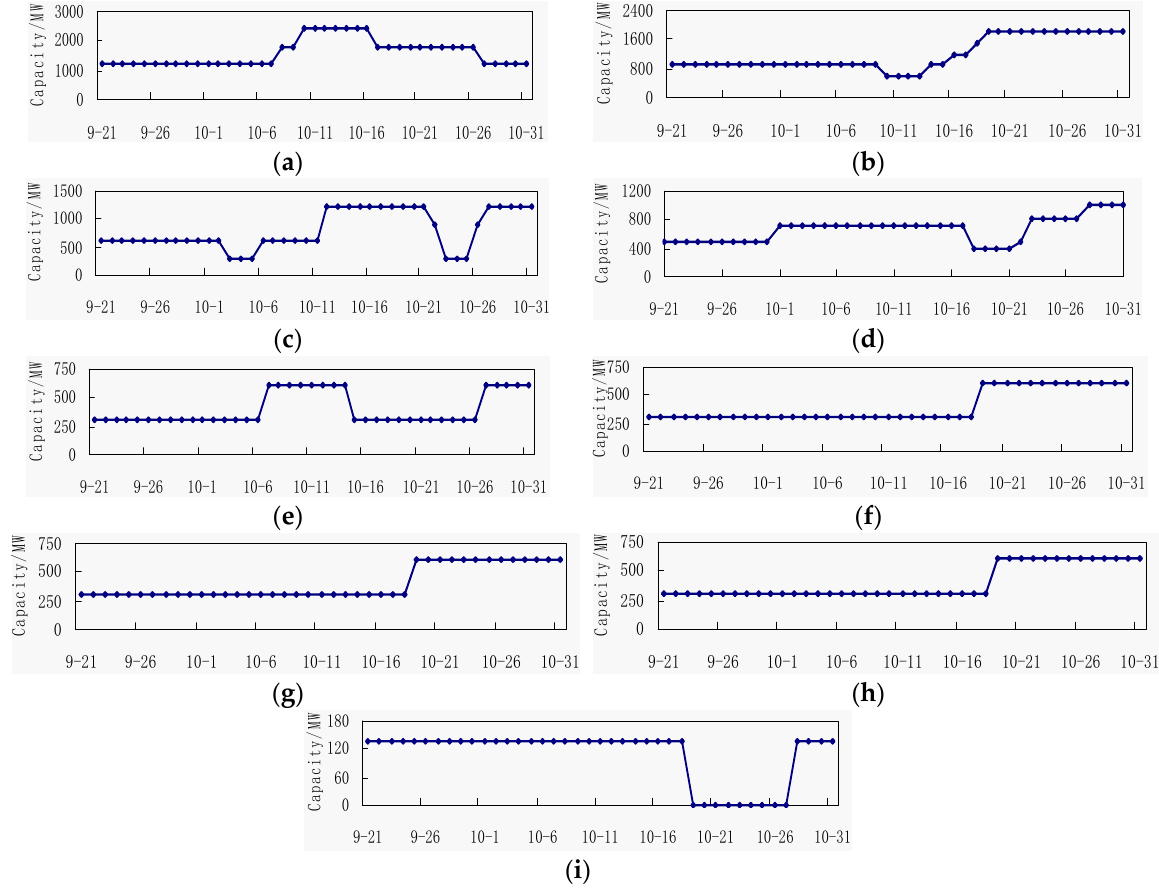
Figure 9. Results of thermal plants: ( a ) Plant A; ( b ) Plant B; ( c ) Plant C; ( d ) Plant D; ( e ) Plant E; ( f ) Plant F; ( g ) Plant G; ( h ) Plant H; ( i ) Plant Table 3. Results of generation requirements for plants in October (MW).